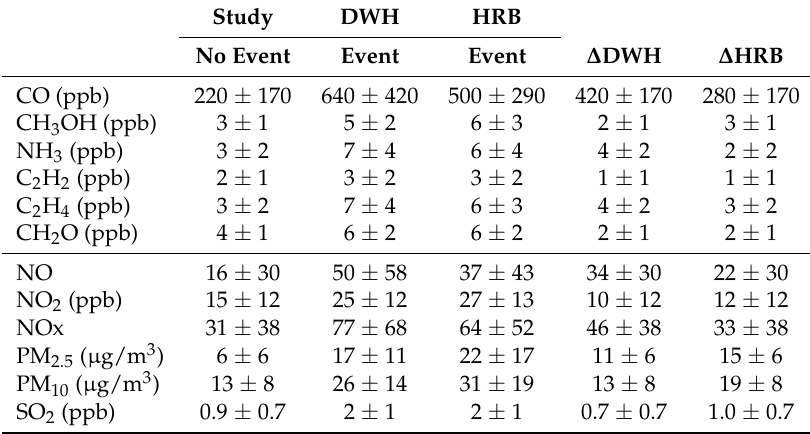
Table 3. Averaged concentrations of pollutants throughout the campaign in the absence of smoke events and during domestic wood-heater and hazard reduction burn events. Averaged concentrations in the absence of smoke events are subtracted from concentrations during the events to give the respective averaged enhancements during domestic wood heating ( ∆ DWH) and hazard reduction burns ( ∆ HRB). Uncertainties quoted are standard deviations of the average concentrations. The standard deviations in the average background amounts are used to estimate the uncertainties in the enhancements as the choice of background to subtract is the dominant uncertainty. Study DWH HRB No Event Event Event ∆ DWH ∆ HRB CO (ppb) 220 ±